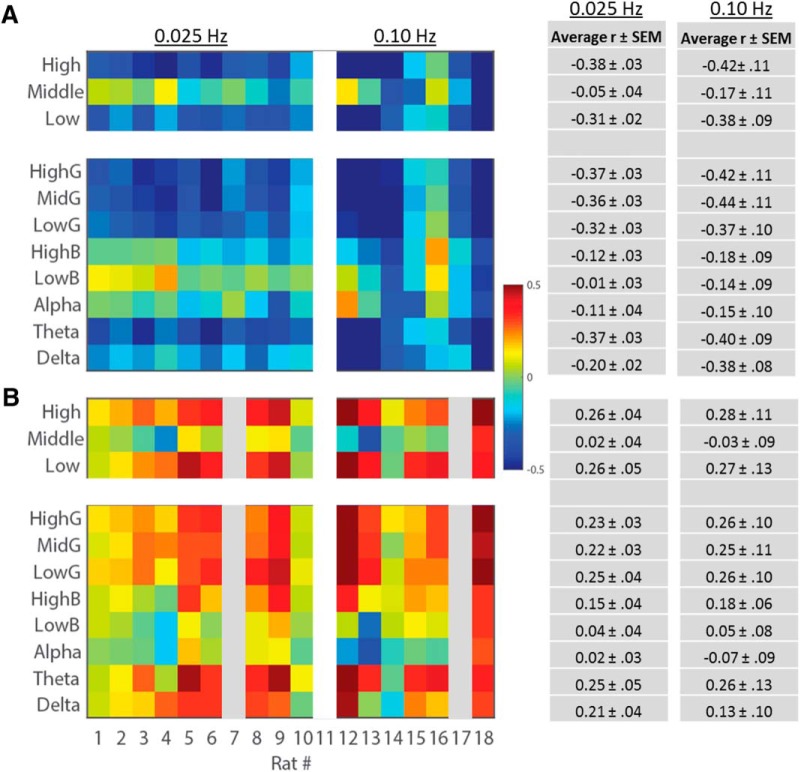
Correlations between antecedent EEG power and fEPSP slope (A) or PS amplitude (B) at stimulation frequencies of either 0.25 or 0.10 Hz. Heat maps depict correlations for each animal for each frequency bin while reported r values reflect the average r value observed across all rats. Low- and high-frequency BLP and fEPSP slope are negatively correlated while these same frequency bins are positively correlated with PS amplitude. PS amplitude could not be consistently quantified for rat 7 or 17. For frequency bin labels, G = γ; B = β.